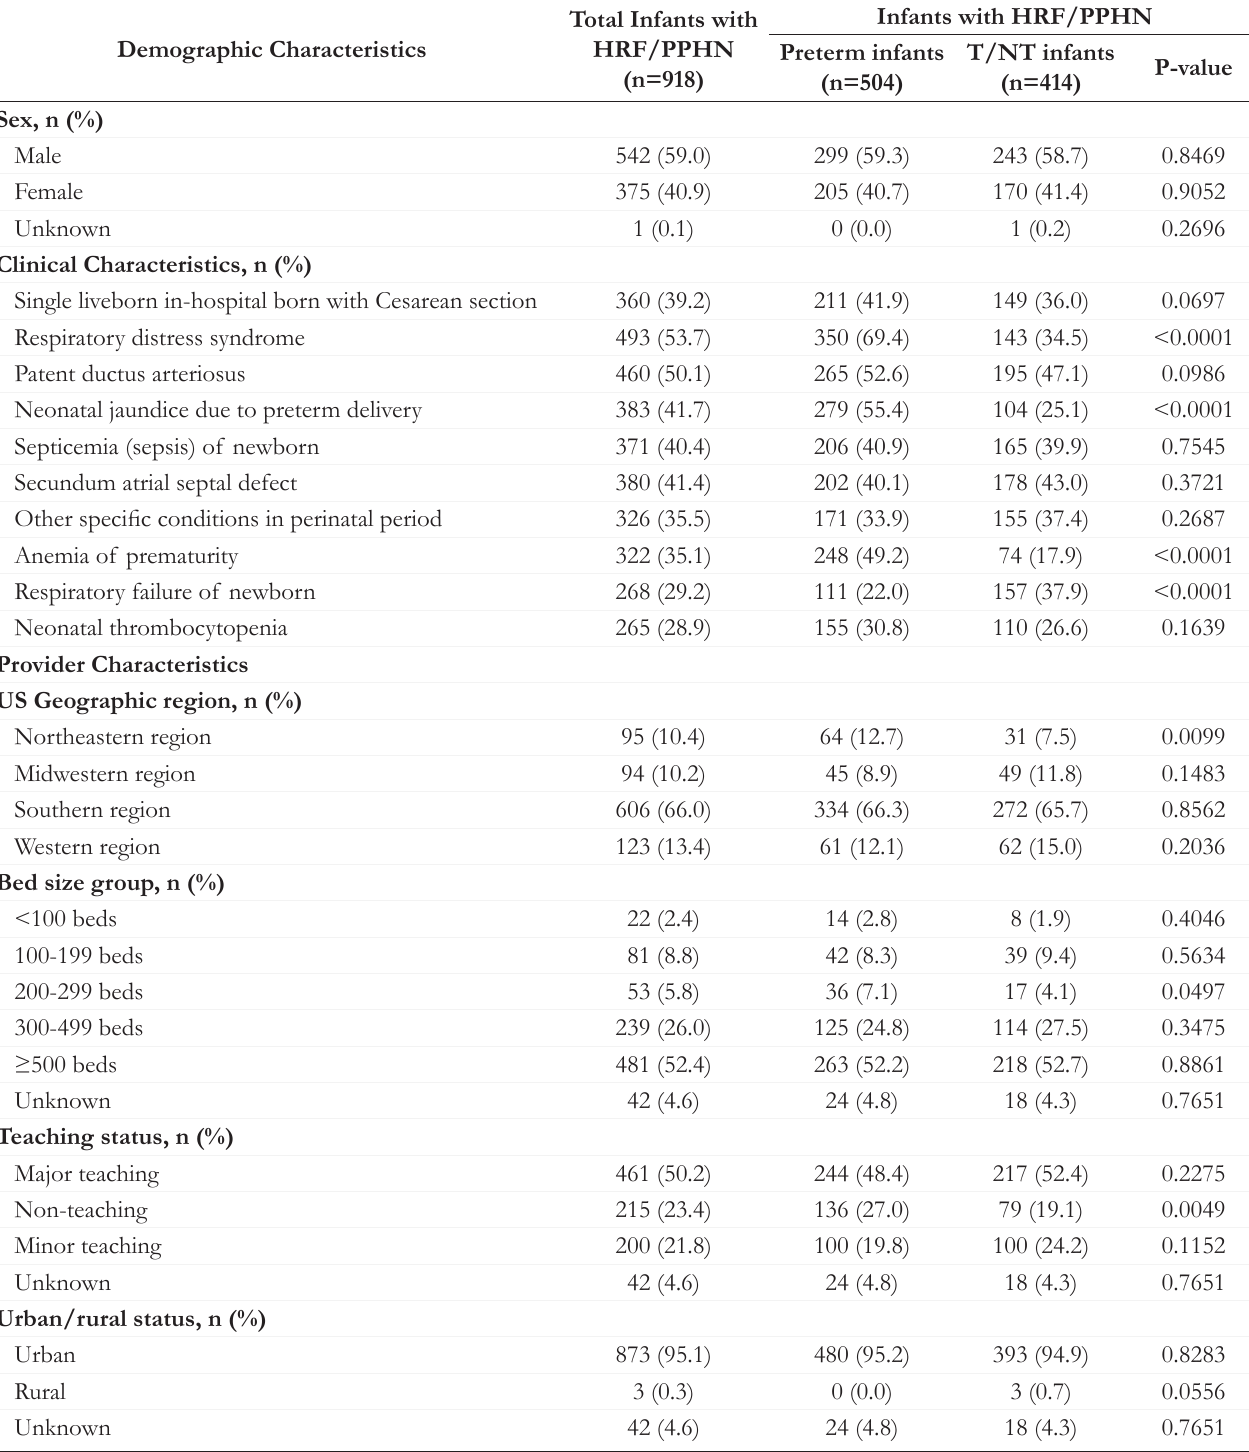
Table 1. Socio-demographic and Provider Characteristics Among Infants diagnosed with HRF/